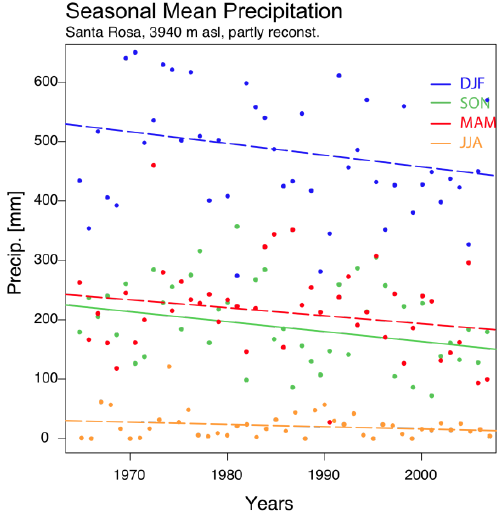
Figure 7. Linear trend for seasonal precipitation sums from the station Santa Rosa. Dashed trend lines indicate where the p-value is above the significance level 0.005 (cf. Table 7).